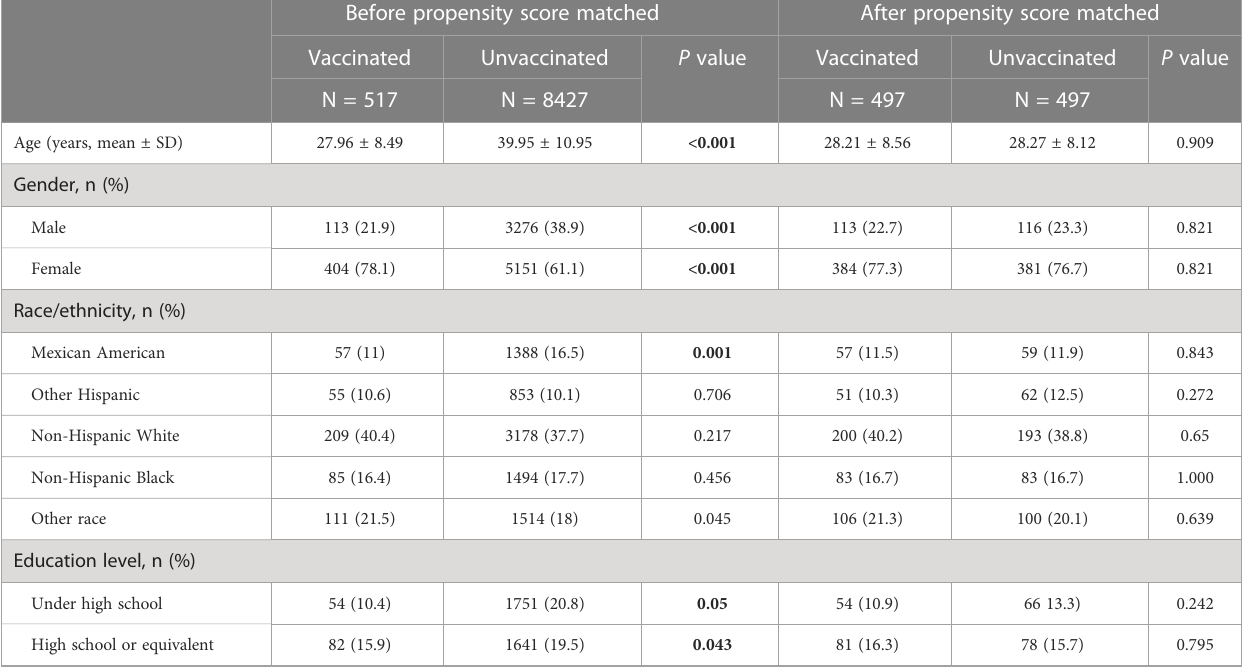
TABLE 3 Demographic characteristics of HPV immunization cohort before weighting. Before propensity score matched After propensity score matched Vaccinated Unvaccinated P value Vaccinated